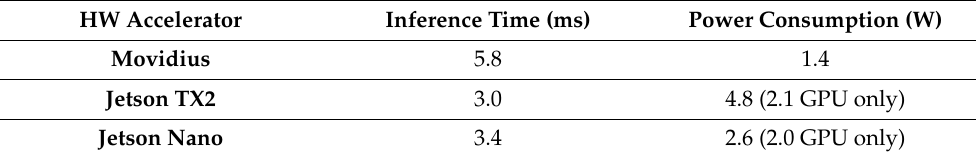
Table 3. Hardware accelerators performance